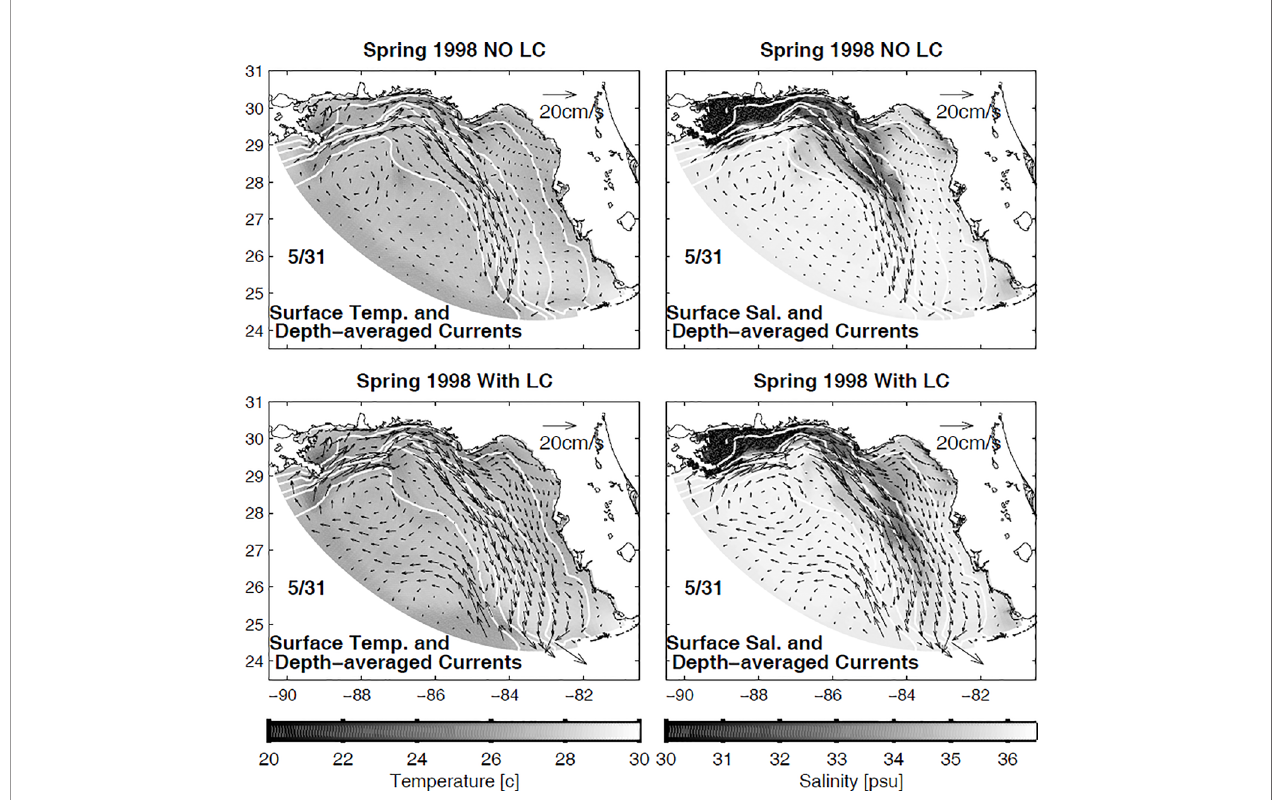
FIGURE 8 | Simulated WFS responses to local forcing alone (top panels) and local plus, Loop Current forcing (bottom panels) as sampled on May 31, 1998, a time when the Loop Current was in contact with west Florida escarpment near the Dry Tortugas. Shown are depth averaged currents superimposed on either surface temperature (left panels) or surface salinity (right panels). Note the full WFS responses with the inclusion of the Loop Current forcing (from Weisberg and He,